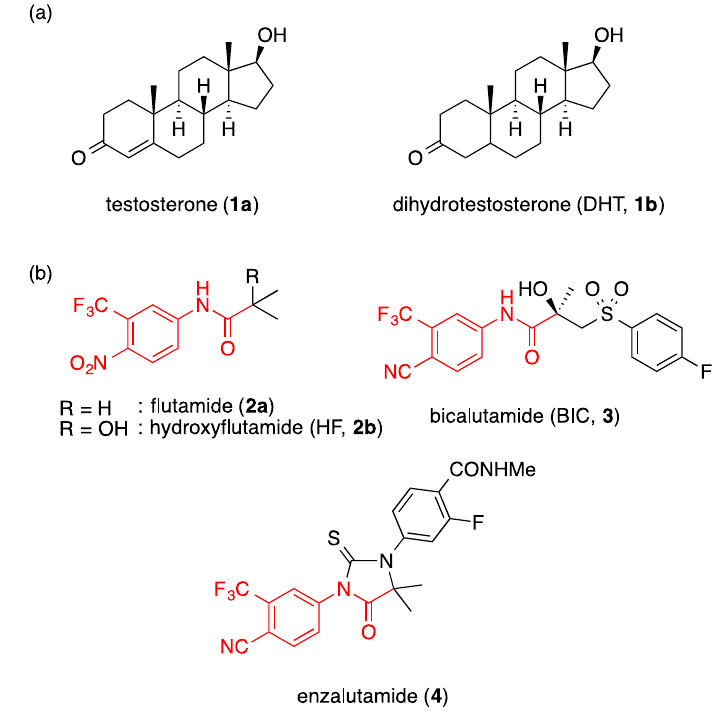
Figure 1. Structures of ( a ) endogenous androgens and ( b ) typical nonsteroidal AR antagonists.